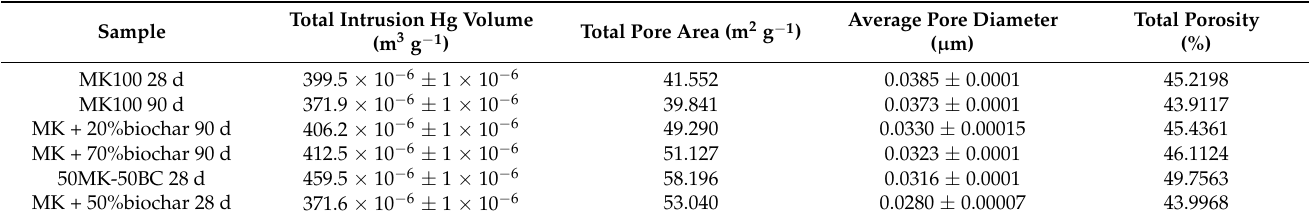
Table 5. MIP parameters determined for the different compositions (MK: metakaolin; B: biochar).